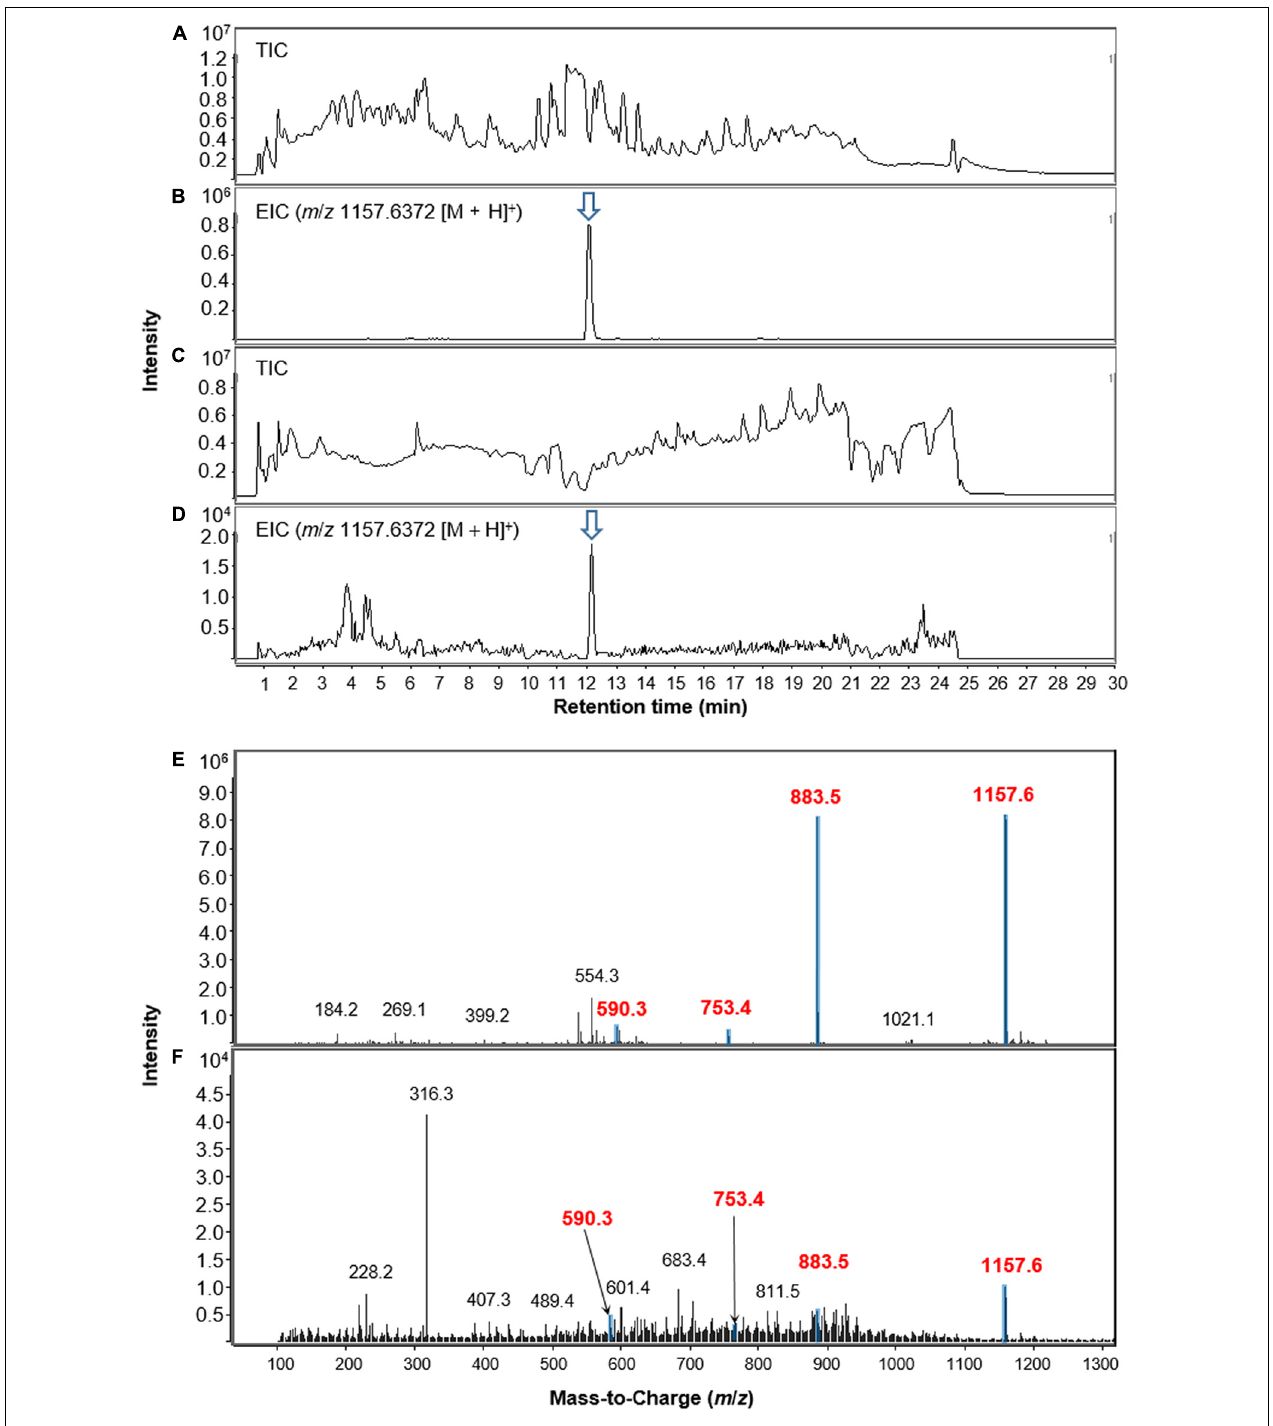
FIGURE 5 | LC-MS chromatograms of lobophorin analogs obtained from extracts of S. olivaceus JB1 in broth medium and the foliage and petioles of M . japonica in positive ion mode. (A) Total ion current (TIC) chromatogram of liquid culture broth of S. olivaceus JB1. (B) Extracted-ion chromatogram (EIC) of the liquid broth of S. olivaceus JB1 (lobophorin A, m / z 1157.6372 [M + H] + ). (C) Total ion current (TIC) chromatogram of the methanol extract of the dried leaf material of M. japonica . (D) Extracted-ion chromatogram (EIC) of methanol extract of M. japonica leaves (lobophorin A, m / z 1157.6372 [M + H] + ). (E) MS fragmentation patterns of lobophorin A detected from the liquid culture of S. olivaceus JB1 and (F) methanol extract from the dried leaf material of M. japonica . The arrows indicate exact elution times of the extracted ions.